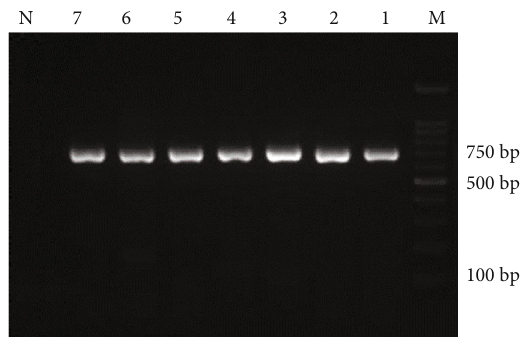
Figure 2: PCR results using the ITS forward and reverse primers for ITS1 gene fragment obtained from the Fasciola samples in this study, line marker M, lines 1-7 of Fasciola samples and line N negative control.